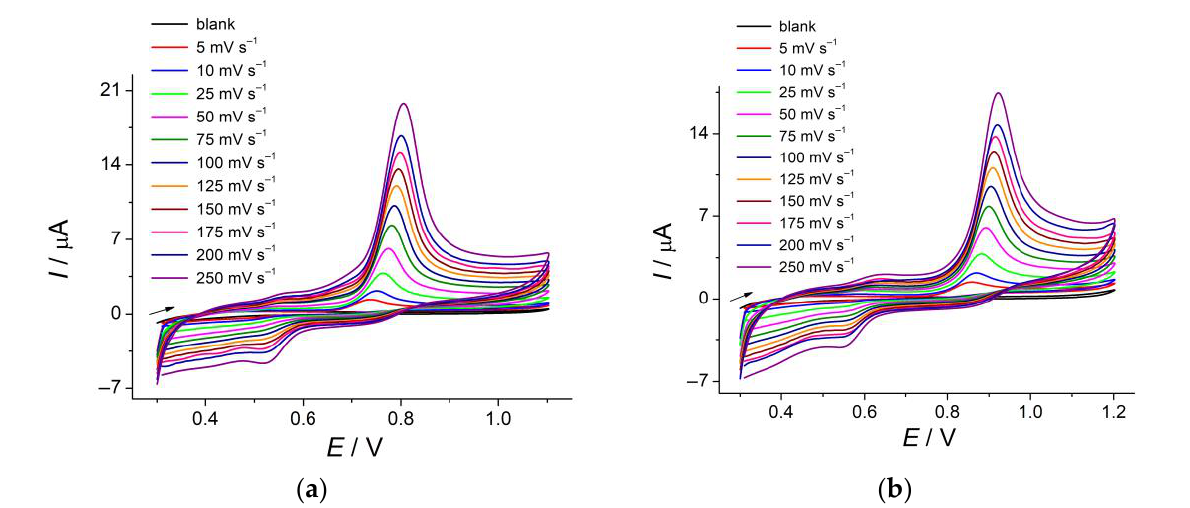
Figure 8. Cyclic voltammograms of aromatic aldehydes at the poly( p -ABA)-modified electrode in the Britton – Robinson buffer pH 2.0 at various potential scan rates: ( a ) 100 µM of syringaldehyde; ( b ) 100 µM of vanillin. Table 3. Effect of the potential scan rate on the voltammetric characteristics of aromatic aldehydes at the poly( p -ABA)-modified electrode in Britton – Robinson buffer pH 2.0.